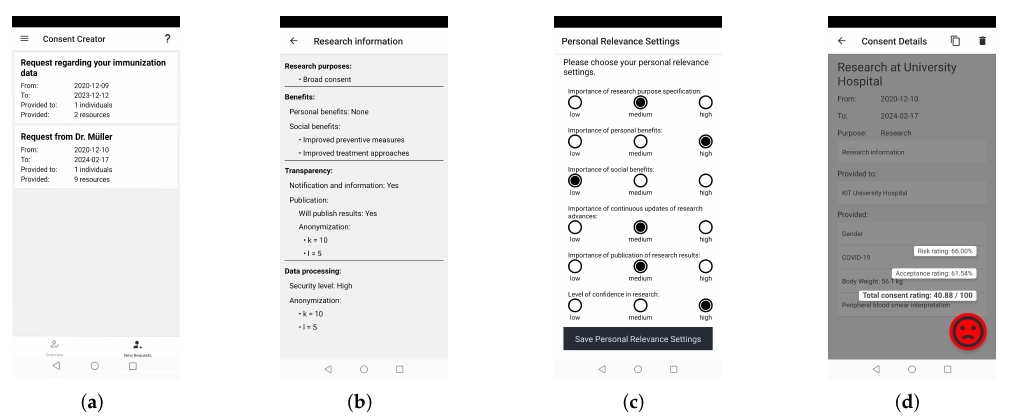
Figure 1. Screenshots of the CPIQ implementation in the “Patient App” (Source: [28]). ( a ) Consent requests view. ( b ) Research information view. ( c ) Personal relevance setting view. ( d ) Consent privacy impact rating view.